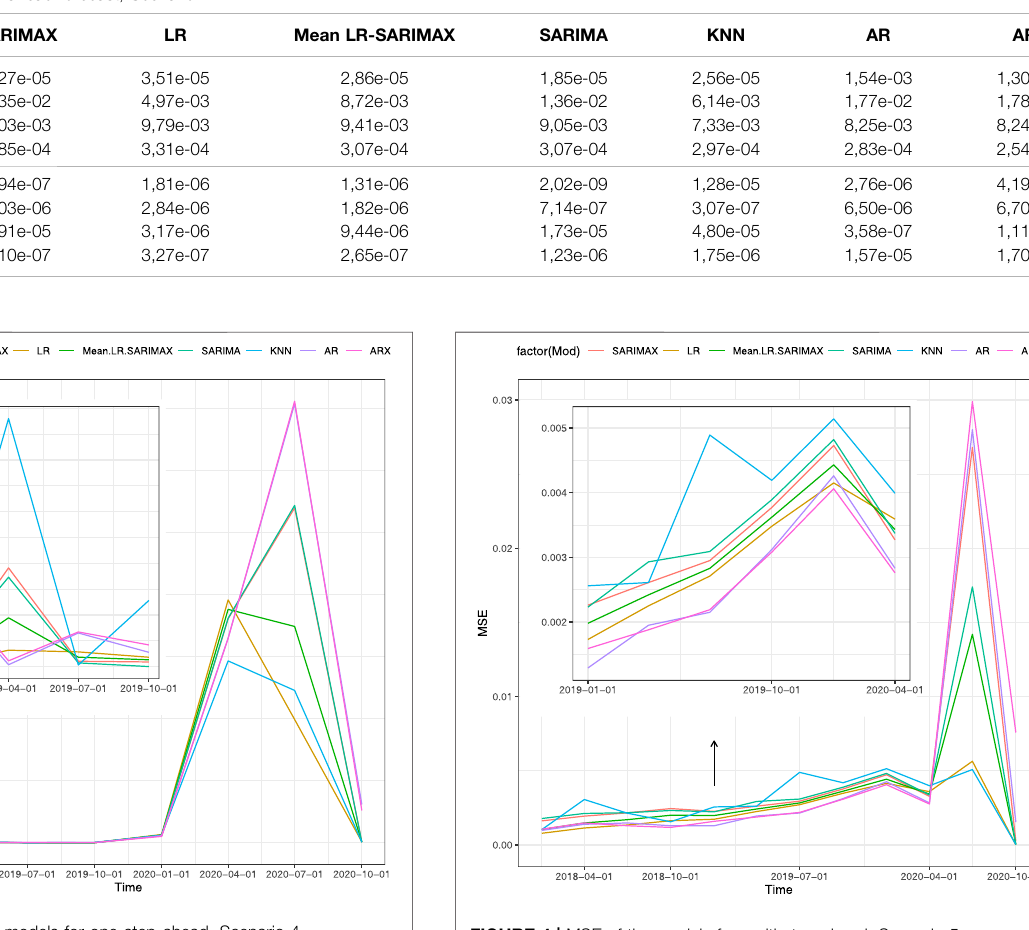
TABLE 3 | MSE One-step-ahead forecast, Scenario 4.